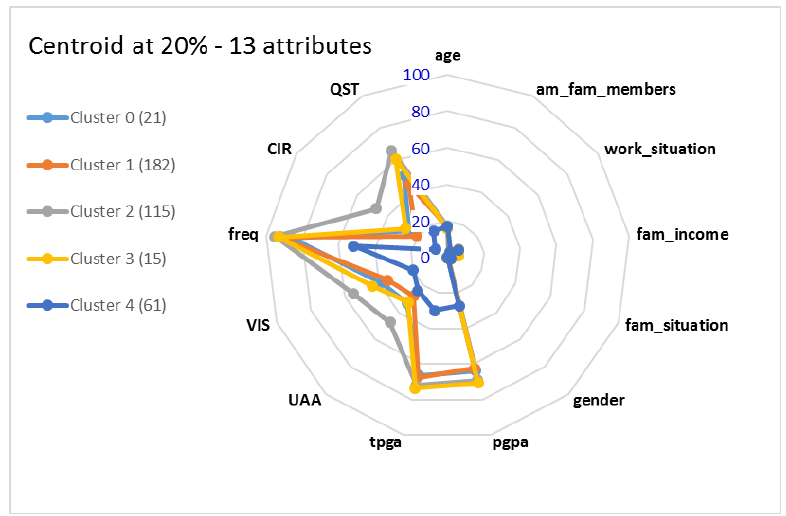
Figure 6. K-means summary at M1. Polygons are cluster centroids and points represent the value of the centroid for each attribute.